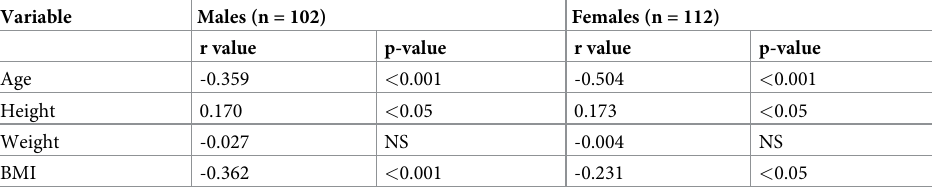
Table 3. Pearson correlations between the variables and the 2MWD (m).